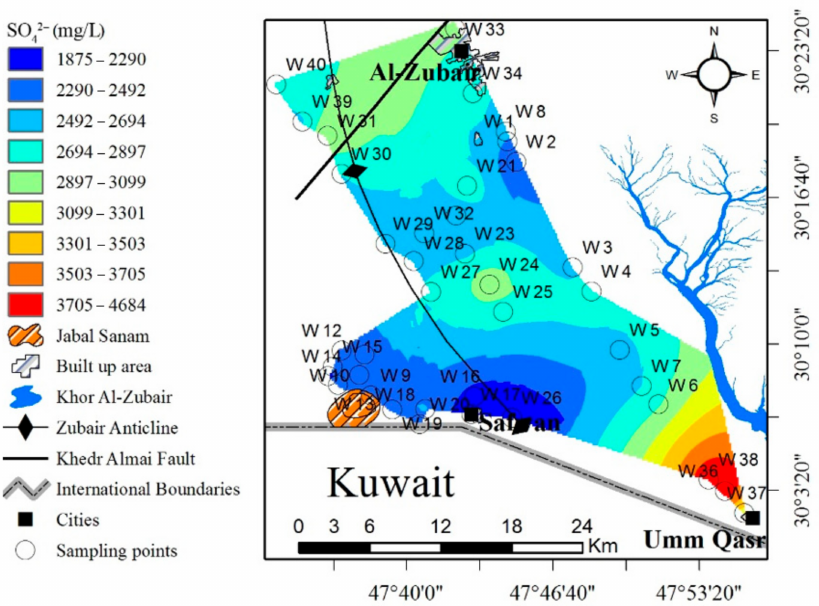
Figure 9. Distribution of SO 42 − in groundwater in the